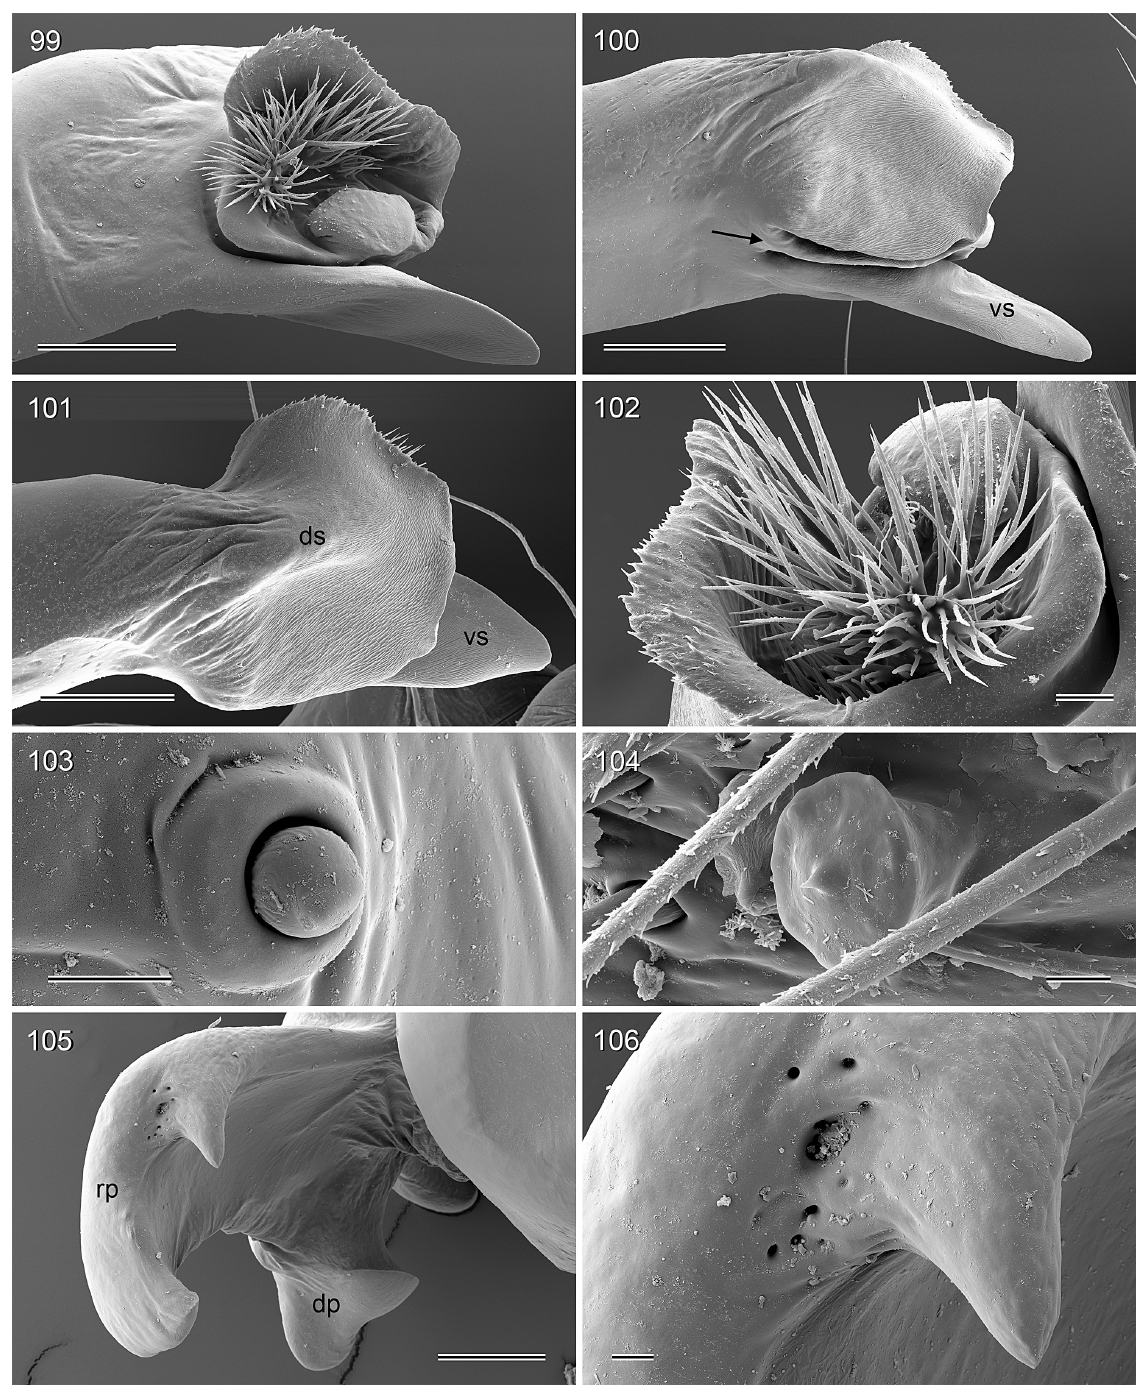
Figs 99–106. Stygopholcus montenegrinus Kratochvíl, 1940; male and female from Studenačka pećina, Montenegro (ZFMK (Ar 22201)). 99 . Tip of right procursus, retrolateral view. 100–101 . Tip of left procursus, prolateral and dorsal views; arrow points at distinctive prolateral sclerite. 102 . Hair-like structures on tip of procursus. 103 . Stridulatory pick on male palpal femur. 104 . Male palpal tarsal organ. 105 . Retrolateral bulbal process, distal view. 106 . Possible glandular pores on retrolateral bulbal process (detail of previous photo). Abbreviations: dp = dorsal process; ds = dorsal sclerite; rp = retrolateral process; vs = ventral sclerite. Scale bars: 99–101, 105 = 100 µm; 102 = 20 µm; 103–104, 106 = 10